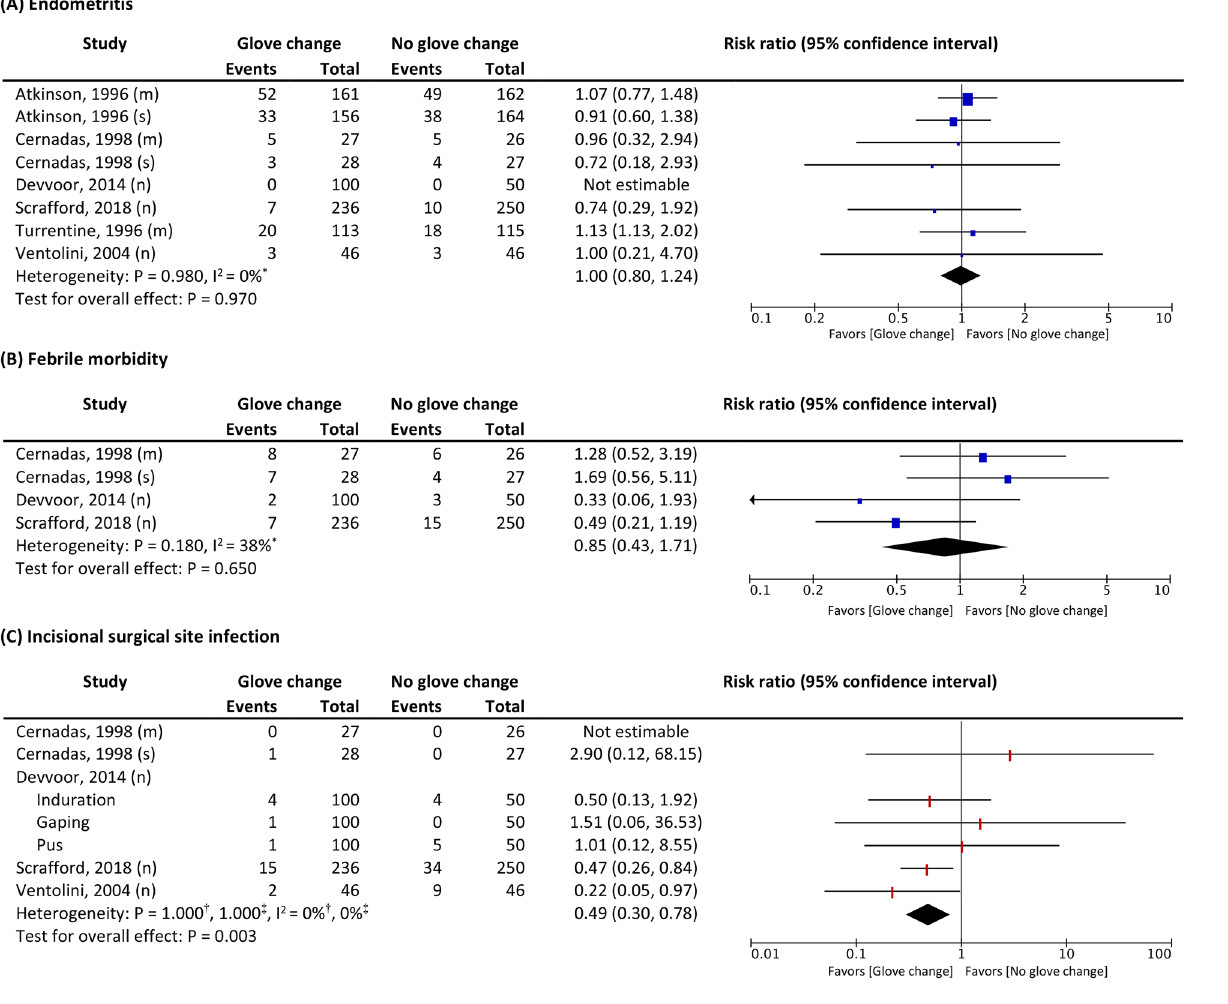
Figure 3. Effects of intervention on ( A ) Endometritis, ( B ) Febrile morbidity, and ( C ) Incisional surgical site infection. (n) = not specified placental delivery method, (m) = manual placental removal, (s) = spontaneous placental removal, * heterogeneity of two-level meta-analysis explained by I 2 , † heterogeneity of three-level meta- 2 ) , ‡ heterogeneity of three-level meta-analysis explained by analysis explained by variance within the study (σ 2 2 variance between the studies (σ 3